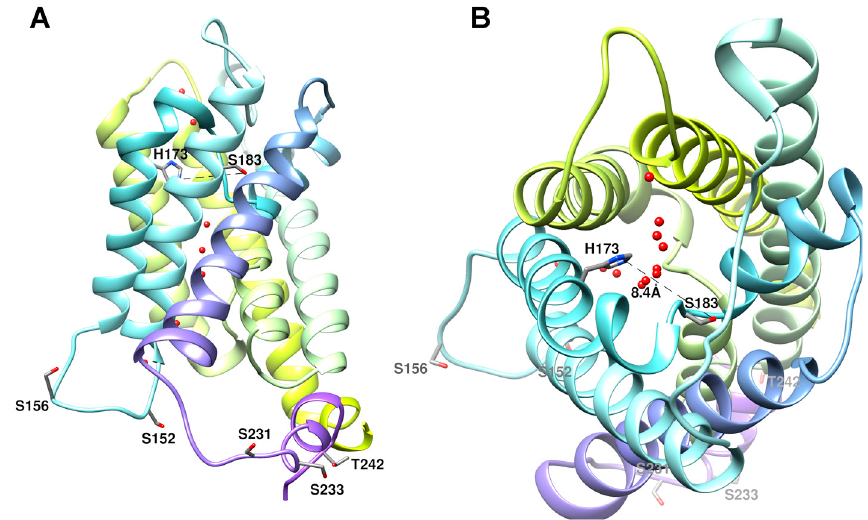
Figure 3. Structure of human AQP5 monomer. ( A ) Side view of the monomer with several phosphorylation consensus sites in the cytoplasmic region (Ser152, Ser156, Ser231, Ser233, and Thr242) shown in licorice representation. Thr259, also a phosphorylation site, is not represented due to the inexistent electron density beyond Pro245 for hAQP5 structure [49]; ( B ) Top view of the monomer with His173 and Ser183 in the selectivity filter (SF) shown in licorice representation. The distance between these two residues (8.4 Å) corresponds to the proposed distance for the SF wide conformation [33]. Water molecules are shown as red spheres along the channel pore. Structures were generated with Chimera (http://www.cgl.ucsf.edu/chimera) and are based on AQP5 X-ray structure (PDB databank code 3D9S).